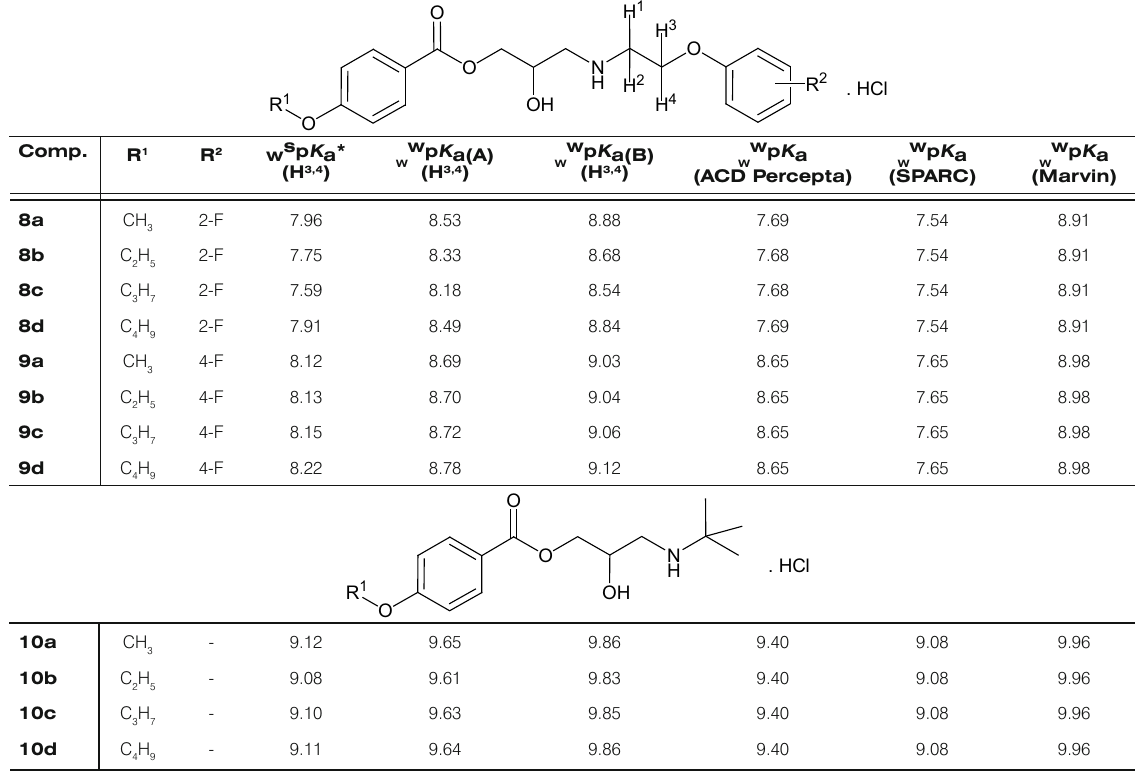
Selected predicted physico-chemical parameters (cid:76)(cid:81)(cid:288)(cid:88)(cid:72)(cid:81)(cid:70)(cid:76)(cid:81)(cid:74)(cid:3) (cid:83)(cid:68)(cid:86)(cid:86)(cid:76)(cid:89)(cid:72)(cid:3) (cid:83)(cid:72)(cid:85)(cid:80)(cid:72)(cid:68)(cid:87)(cid:76)(cid:82)(cid:81)(cid:3) (cid:87)(cid:75)(cid:85)(cid:82)(cid:88)(cid:74)(cid:75)(cid:3) (cid:80)(cid:72)(cid:80)(cid:69)(cid:85)(cid:68)(cid:81)(cid:72)(cid:86)(cid:3) (cid:68)(cid:87)(cid:3) the physiological pH 7.4 of the discussed compounds 8 - 10 (cid:3)(cid:76)(cid:81)(cid:3)(cid:70)(cid:82)(cid:80)(cid:83)(cid:68)(cid:85)(cid:76)(cid:86)(cid:82)(cid:81)(cid:3)(cid:90)(cid:76)(cid:87)(cid:75)(cid:3)(cid:72)(cid:86)(cid:80)(cid:82)(cid:79)(cid:82)(cid:79)(cid:3)(cid:68)(cid:81)(cid:71)(cid:3)(cid:288)(cid:72)(cid:86)(cid:87)(cid:82)(cid:79)(cid:82)(cid:79)(cid:29)(cid:3)(cid:71)(cid:76)(cid:86)(cid:87)(cid:85)(cid:76)(cid:69)(cid:88)(cid:87)(cid:76)(cid:82)(cid:81)(cid:3) ), solubility (log S ), ionizability (p K (cid:70)(cid:82)(cid:72)(cid:73)(cid:287)(cid:70)(cid:76)(cid:72)(cid:81)(cid:87)(cid:3)(cid:11)(cid:79)(cid:82)(cid:74)(cid:3) D 7.4 permeability (Pe [cm/s]). Calculated by ACD/Percepta ver. Comp.